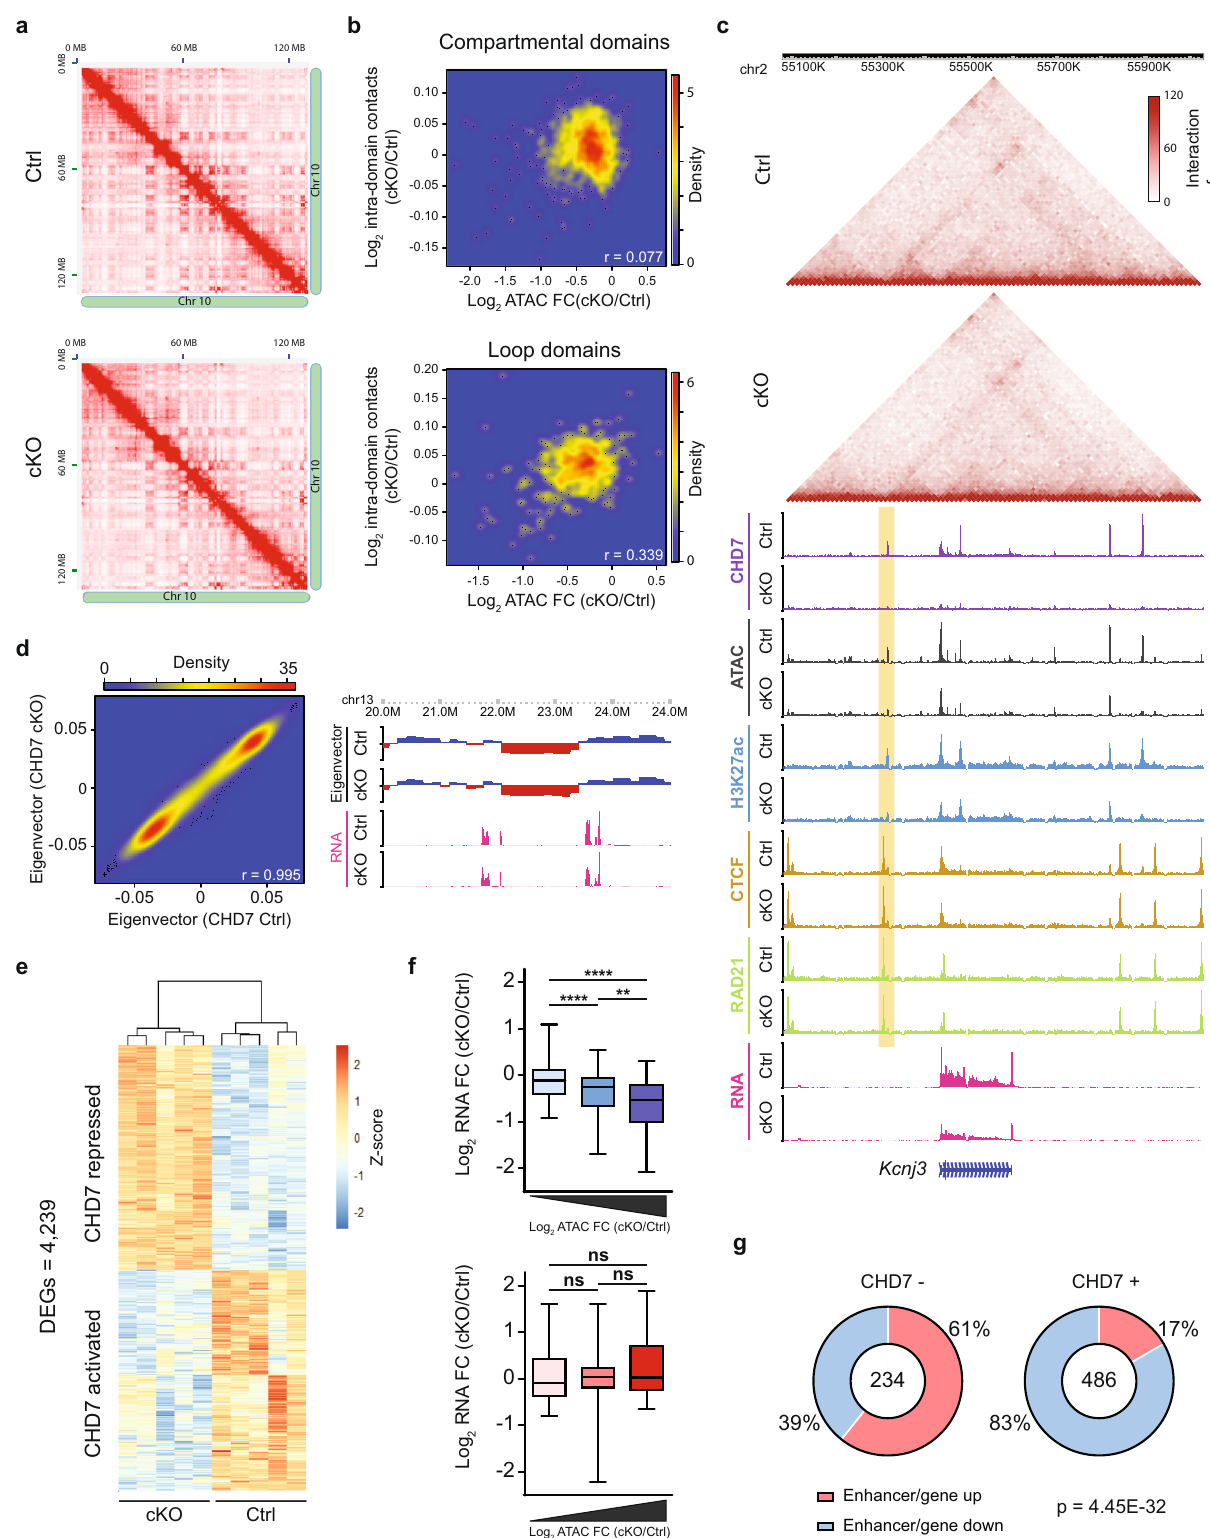
cerebellum (Fig. 3d). Collectively, these data suggest that CHD7 Fig. 2f, g). For example, genomic interactions within a loop chromatin remodeling activity at enhancers occurs independently domain near the gene Kcnj3 were minimally altered upon loss of of alterations in genome architecture. CHD7 in tandem with unaltered binding of RAD21 and CTCF We next assessed if alterations in epigenomic states at (Fig. 3c). Furthermore, compartmentalization analyses revealed enhancers in conditional CHD7 knockout mice corresponds to little change in A/B compartments and a high eigenvector differential expression of genes that remain linked to these correlation between conditional CHD7 knockout and control NATURE COMMUNICATIONS| (2021) 12:5702